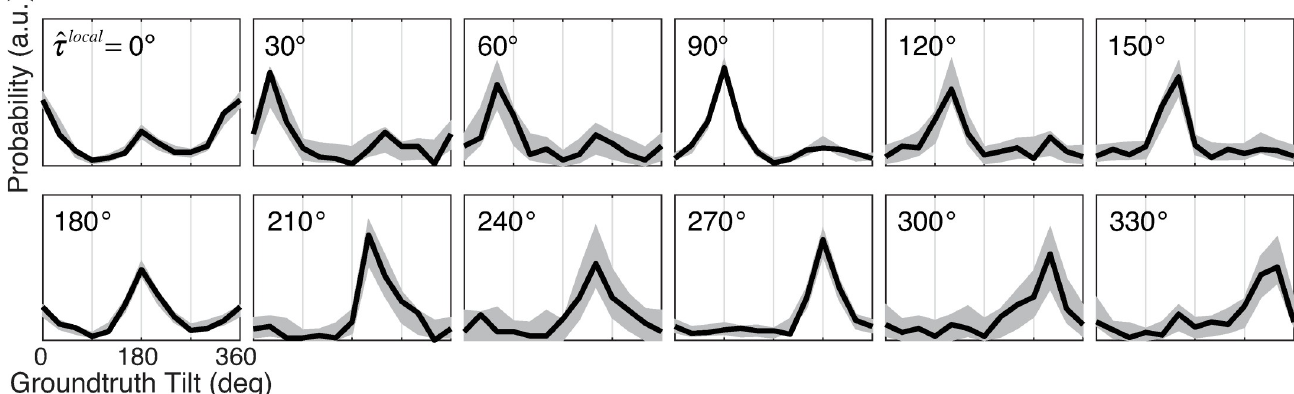
Fig 6. Conditional distributions of groundtruth tilt given the value of the tilt estimate. Each subplot shows the distribution of groundtruth tilt given a particular local estimate value p ð t j ^ t local Þ . For example, the fifth subplot in the first row shows the distribution of groundtruth tilts given that the local tilt estimate had a value of 120 º (i.e., p ð t j ^ t local ¼ 120 � Þ ). The fact that the conditional distributions of groundtruth tilt are approximately shift-invariant indicates that each local tilt estimate, regardless of its value, provides approximately equally reliable information about groundtruth tilt. Gray regions represent 95% confidence intervals from Monte Carlo simulations of 1000 experimental datasets. Confidence intervals at non-cardinal tilts (e.g., ^ t local = 30 º , 60 º , 120 º , 150 º , etc.) are larger in part because the local model produces fewer non-cardinal tilt estimates, in keeping with the prior probability distribution over tilt, which has peaks at the cardinal tilts (e.g., τ = 0 º , 90 º , etc.; see Fig 2C).